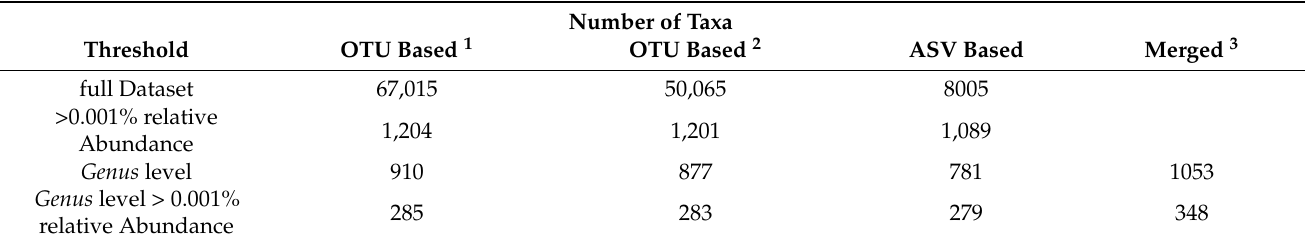
Table 1. Number of taxa derived from the two different sequencing data handling pipelines across different applied abundance and taxa